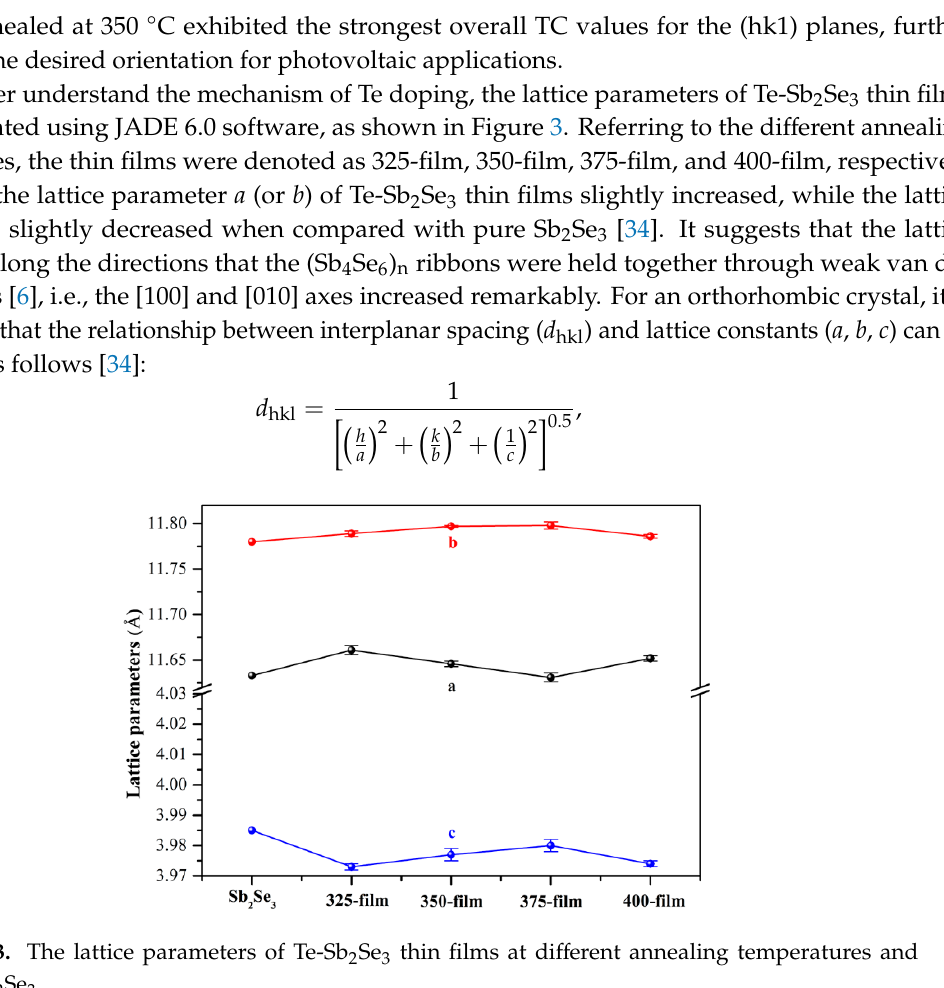
Figure 2. ( a ) XRD patterns of Te-Sb 2 Se 3 thin films on indium tin oxide (ITO) with different annealing temperatures. ( b ) Shift of (230) peak of crystalline Te-Sb 2 Se 3 thin films as shown in XRD patterns compared with pristine Sb 2 Se 3 . ( c ) Texture coefficients of diffraction peaks based on XRD patterns.